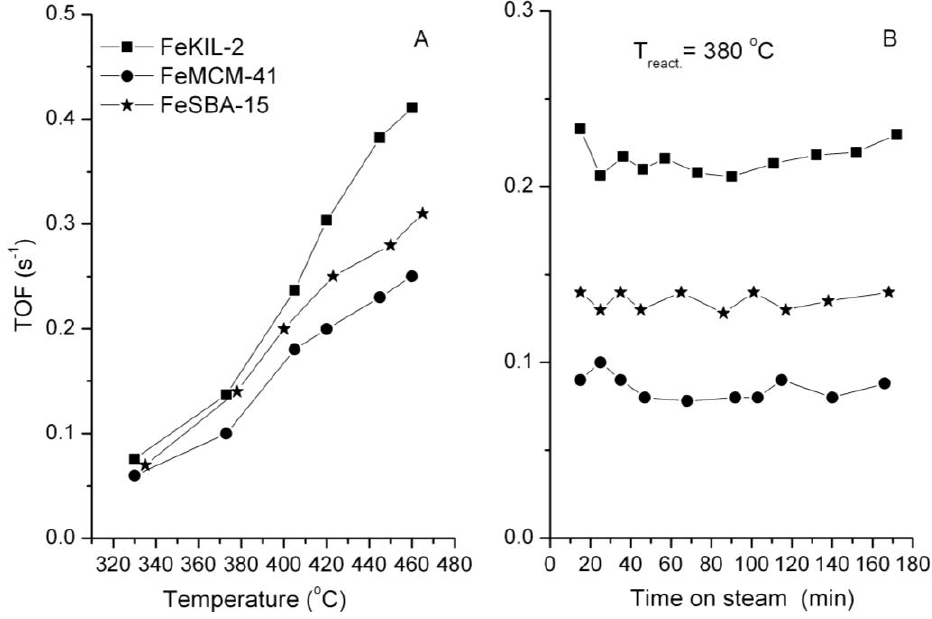
Figure 8. Catalytic activity vs. ( A ) temperature; and ( B ) time on stream at 380 °C on FeKIL-2, FeMCM-41, FeSBA-15 samples (Fe/Si = 0.01). Operating